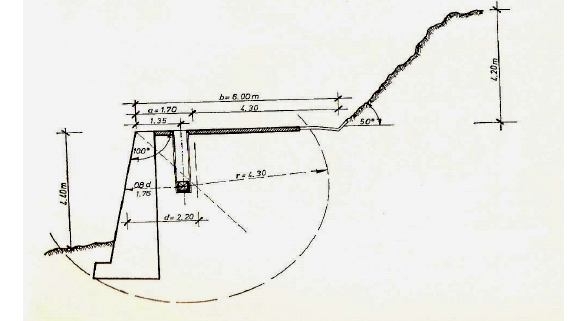
Figure 2 – Plan of mine wells